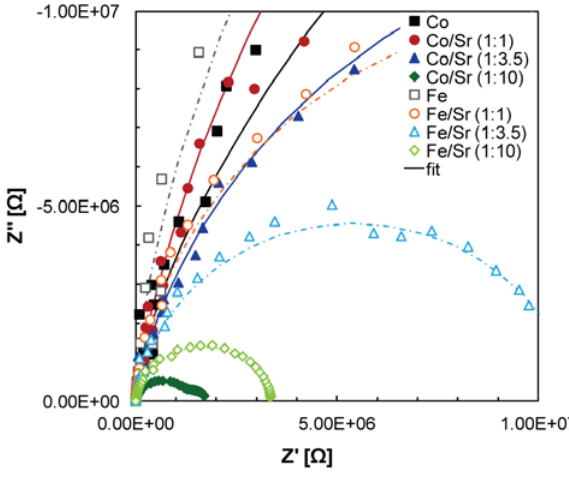
Figure 7. Nyquist plot of EIS measurements and equivalent circuit model for HS alkyd coatings of different drier